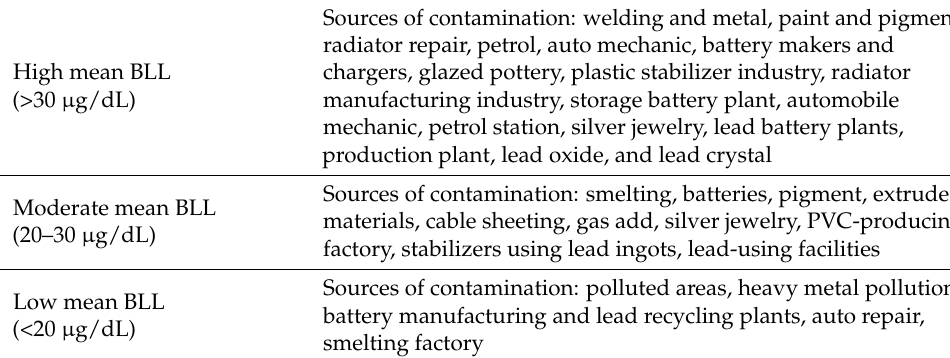
Figure 2. The mean BLL among participants. ES: Effect Size (mean BLL in ug/dL), CI: Confidence Interval (ug/dL), black diamond symbol: point estimate, solid line in the middle of the graph at 0: zero effect size. Table 2. Sources of lead contamination among exposed